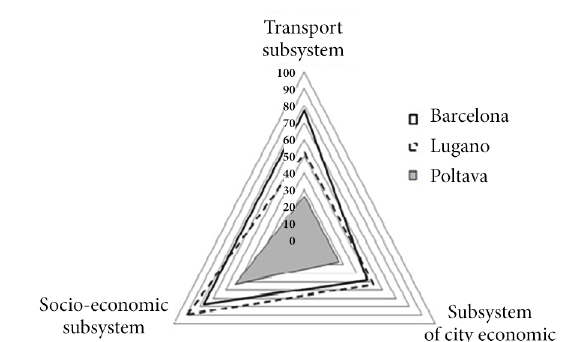
Figure 10. Comparison of estimates of the metabolism efficiency urban environment of Poltava, Barcelona,